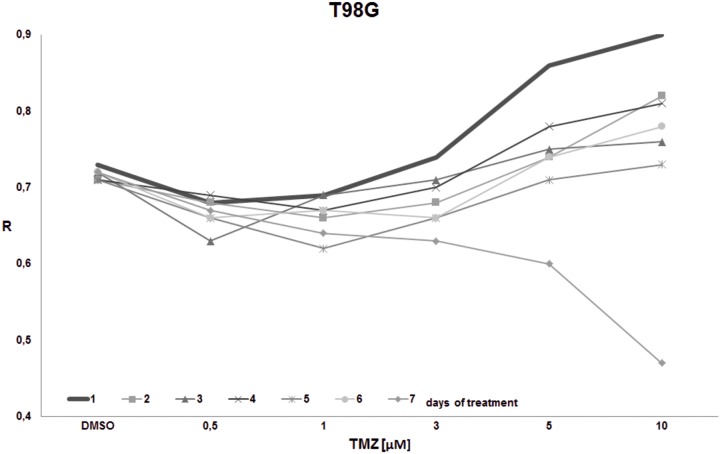
The impact of TMZ exposure period on DNA methylation in T98G cell line.T98G cell culture was treated with the given single dose of TMZ (0.5, 1, 3, 5, 10 μM) and left for 1–7 days. The global DNA methylation was estimated after 1st, 2nd, 3rd, 4th, 5th, and 7th day of incubation. The highest methylation (R) is seen on day 1 in all concentrations. In concentrations over 3 μM we observe increasing DNA methylation. On day 7 a hypomethylating trend is observed potentiated by increasing concentration.